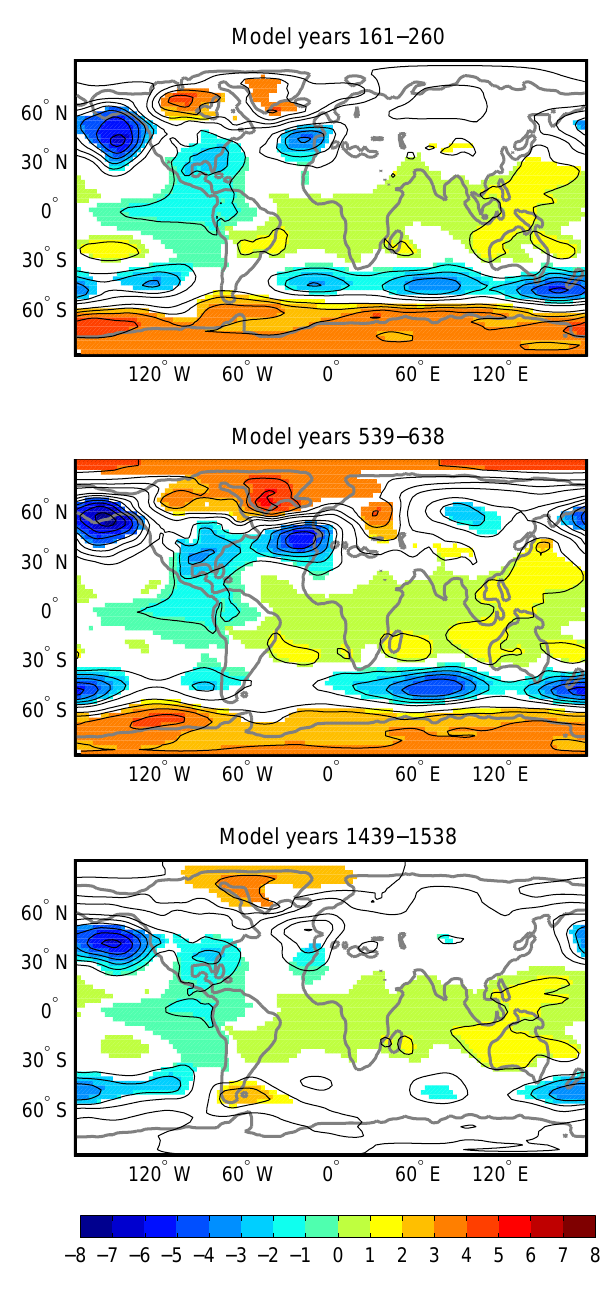
Fig. 9. JFM El Ni˜no – Southern Oscillation teleconnections of mean sea level pressure shown as differences between seasonal averages over El Ni˜no years and La Ni˜na years for 100-yr time-slices of the GS12 simulation. Model years 161–260 (upper panel), 539–638 (middle panel), and 1439–1538 (bottom panel) of the GS12 simula- tion. Units are hPa, contour interval 1hPa (excluding the 0hPa con- tour). In shading, statistically significant differences (at the 95% level) are displayed. The coastline is defined at 20% of the land